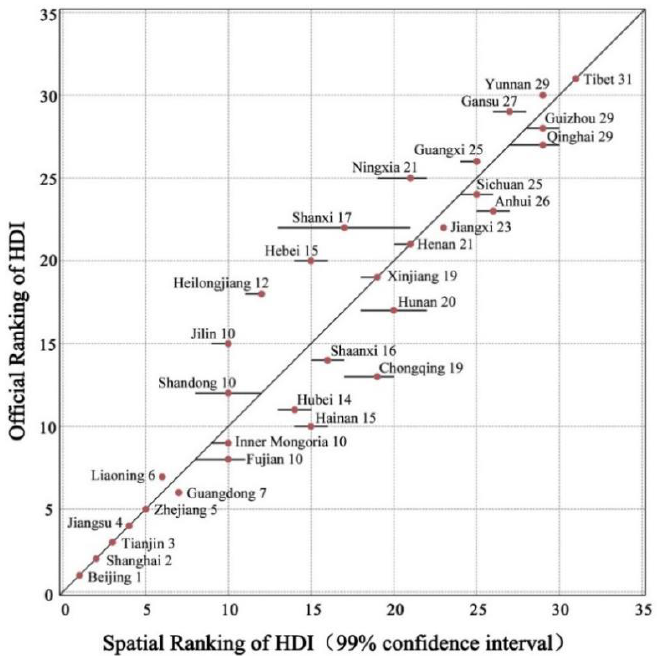
Figure 2. Comparison of Spatial HDI and Traditional HDI (mean values from 2000 to 2018).